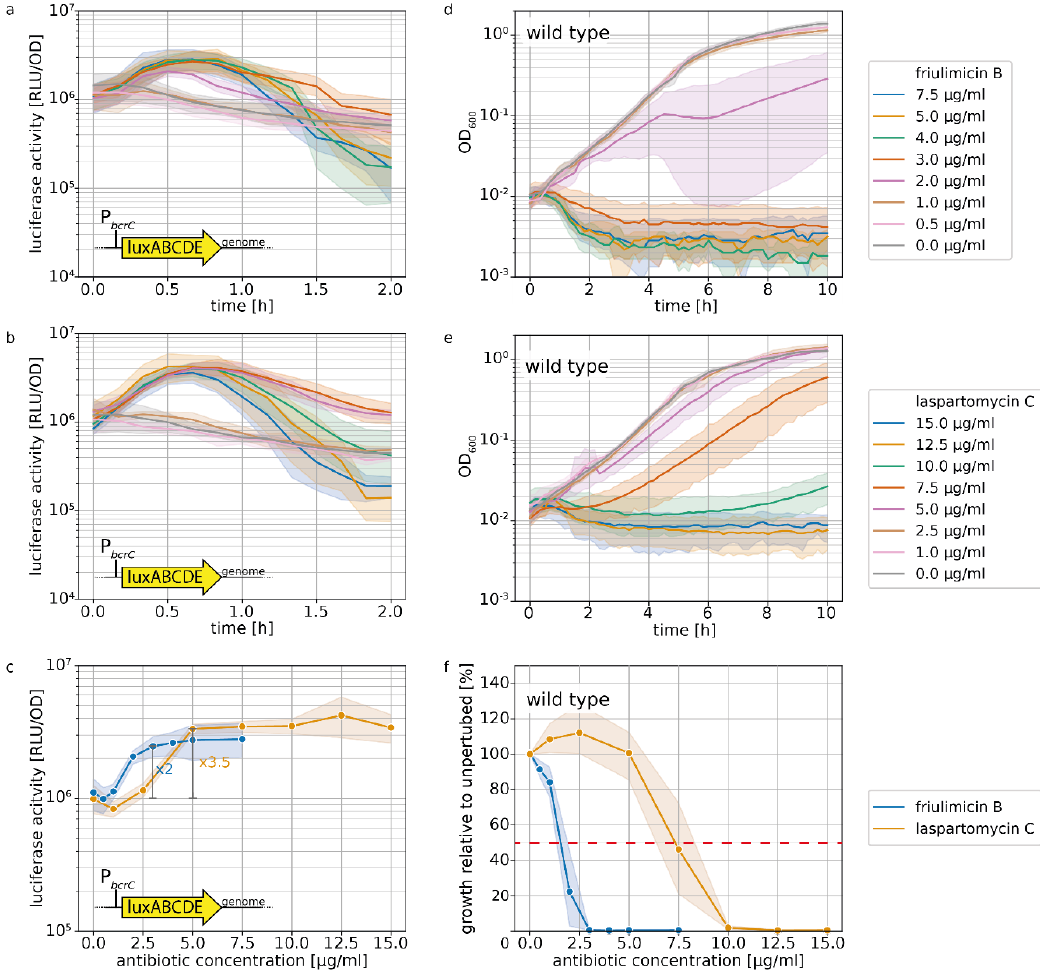
Figure 4. σ M stress response as shown by bcrC promoter activation and growth during friulimicin B and laspartomycin C attack. ( a , b ) Expression of bcrC over time in dependency of different concentrations of friulimicin B ( a ) or laspartomycin C ( b ). ( c ) Dose dependency of the σ M stress response 30 min after antibiotic challenge. Blue and orange lines depict the P bcrC promoter response generated by friulimicin B and laspartomycin C, respectively. The fold change over basal activity is shown at the beginning of the plateau. ( d , e ) Growth after antibiotic challenge with friulimicin B ( d ) or laspartomycin C ( e ). ( f ) Dose dependency of the growth relative to an unperturbed culture 10 h after antibiotic challenge. IC 50 values were determined as the antibiotic concentration reducing bacterial growth by 50% (red dashed line), which was 1.6 and 7.3 μg/mL for friulimicin B and laspartomycin C, respectively. Shaded areas depict 95% confidence intervals.